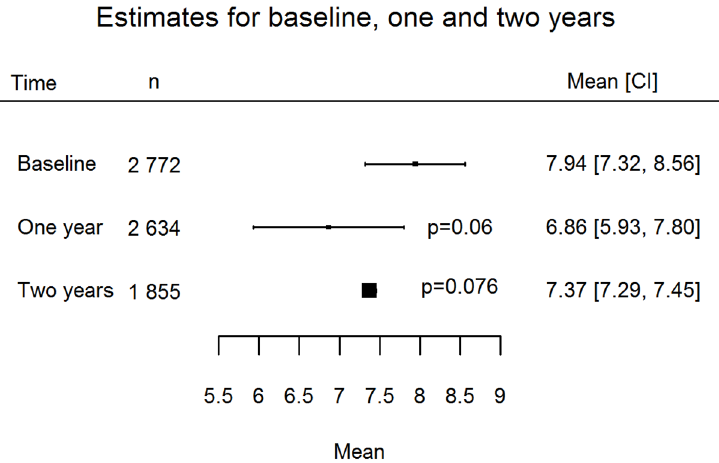
Fig 5. Forest plot of collapsed studies considering HbA1c levels at baseline and two-year